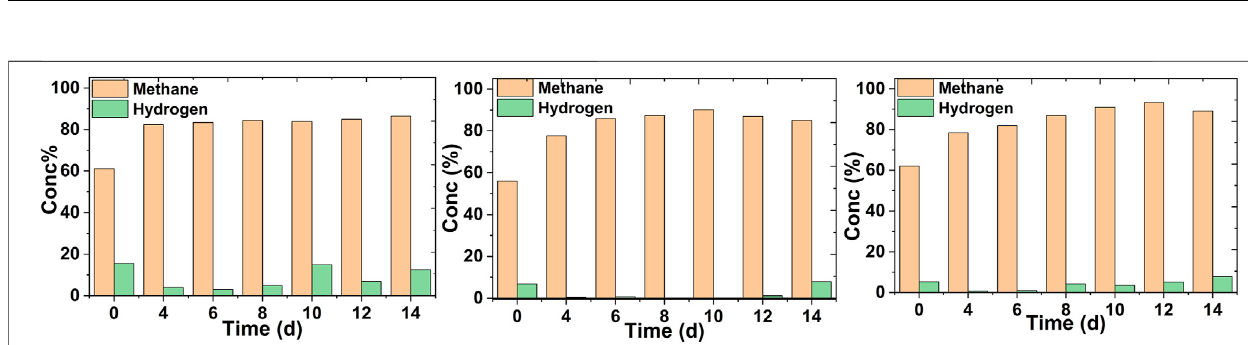
Frontiers in Energy Research |